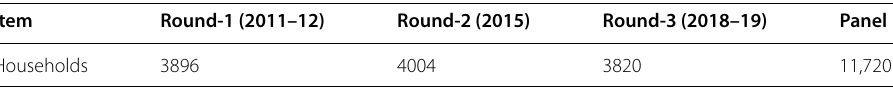
Table 1 Description of the sample Item Round-1 (2011–12) Round-2 (2015) Panel Households